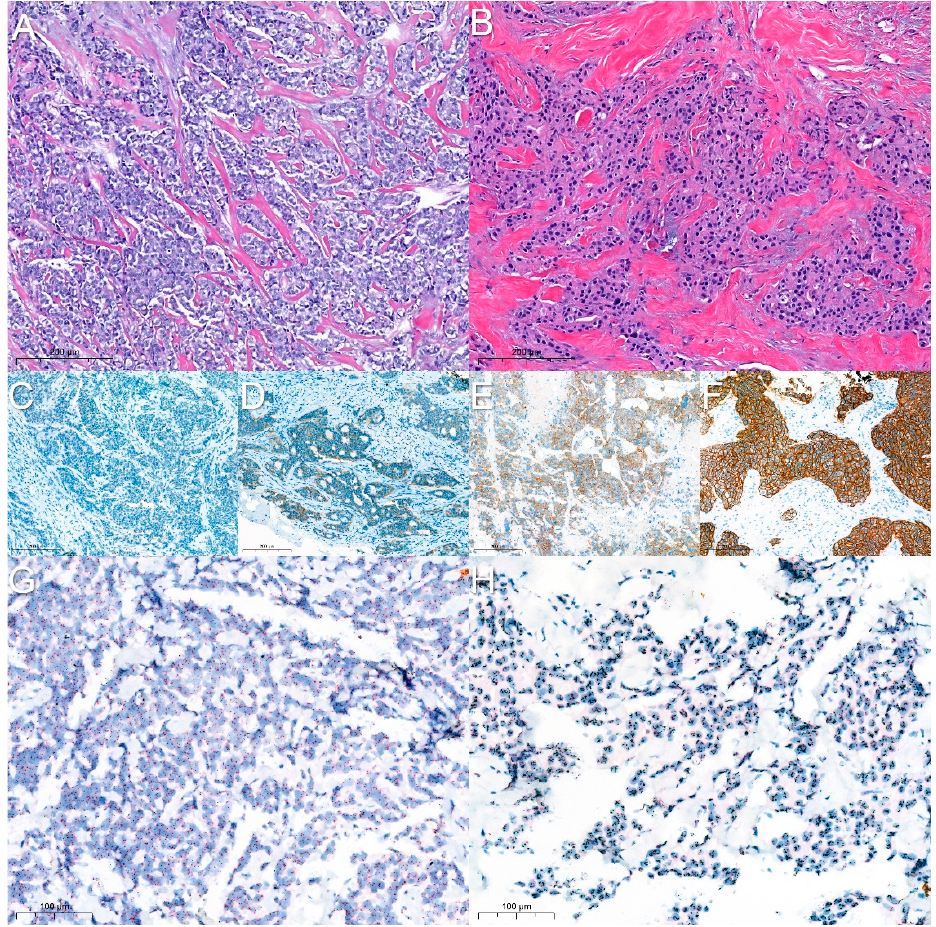
Figure 1. ( A ) HER2-negative BC (HE); ( B ) HER2-positive BC (HE); ( C – F ) HER2 IHC (score of 0, 1+, 2+, and 3+, respectively); ( G , H ) bright-field ISH assay (HER2-negative and HER2-positive,